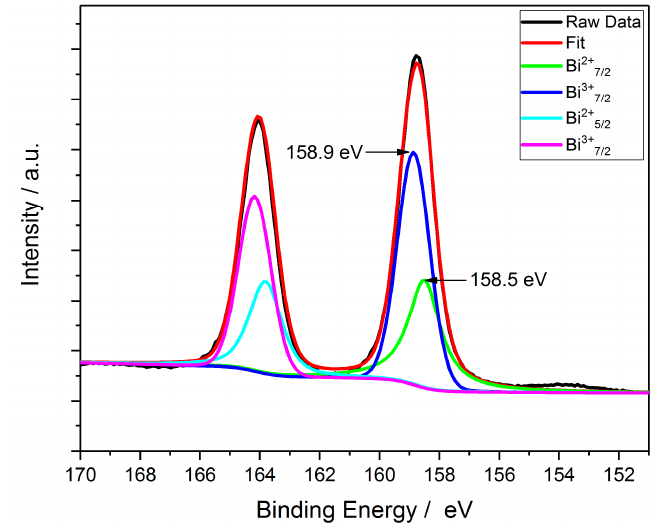
Figure 5. Bi 4 f detail spectra of the coating with splitting in Bi 2+ and Bi 3+ .